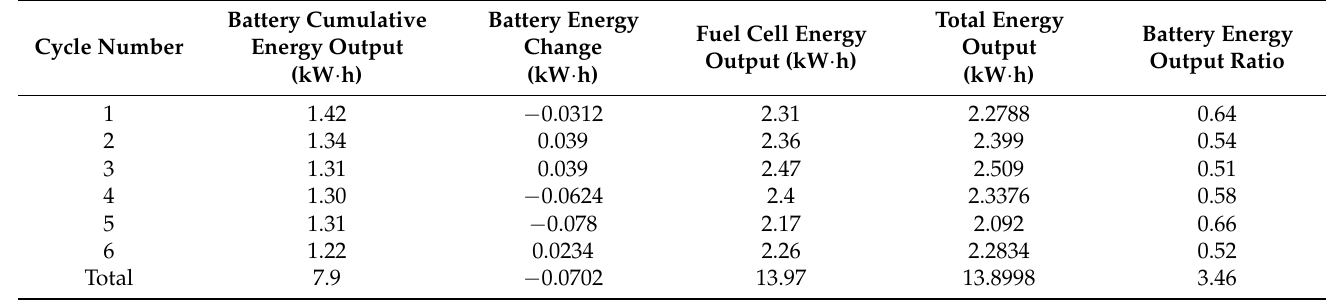
Table 4. The energy output of vehicle